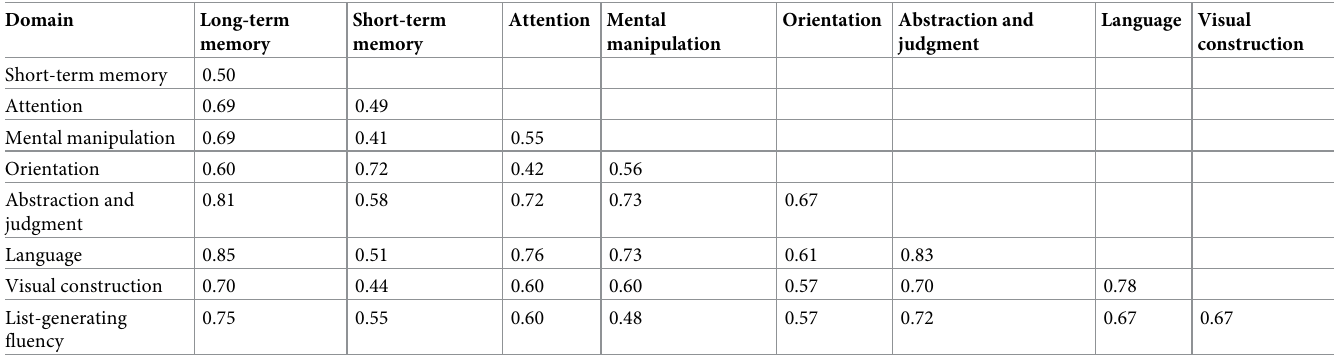
Table 3. Correlations ( r ) among nine domains of the